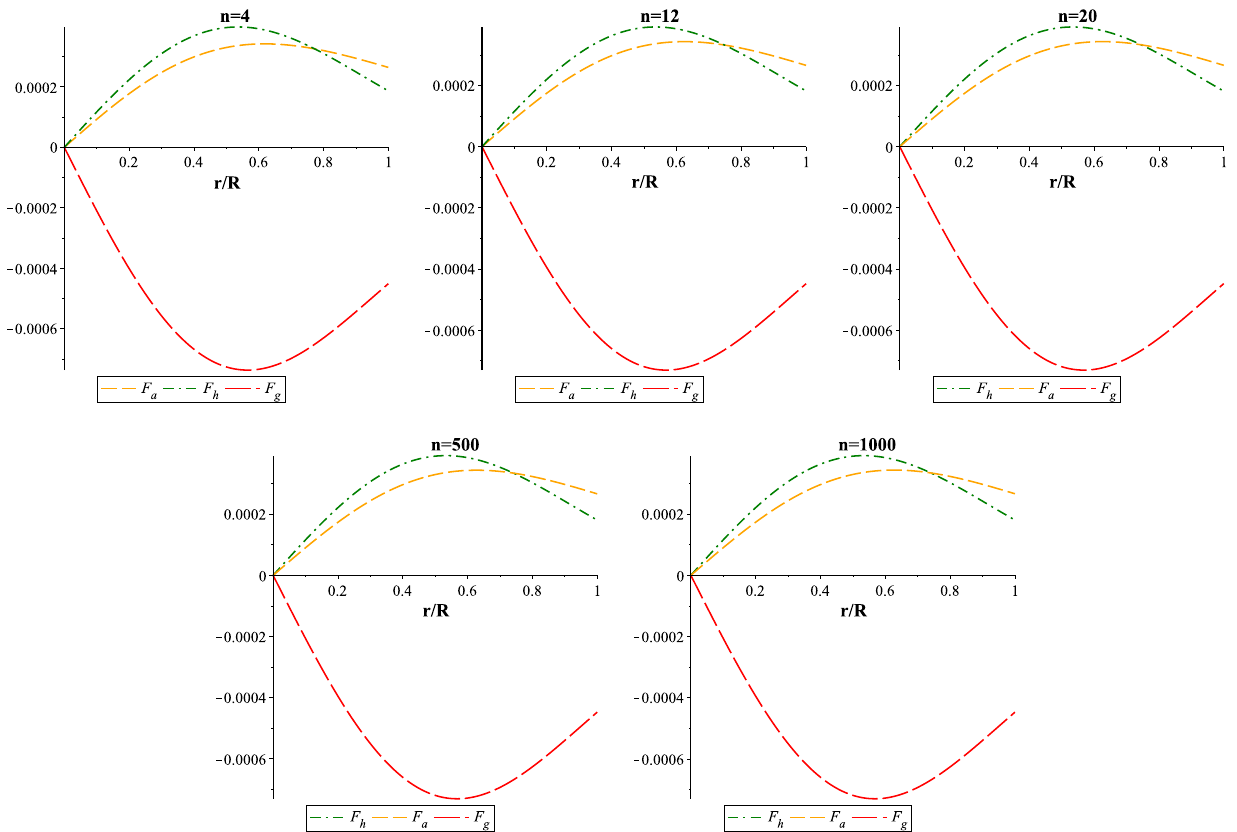
Fig. 8 Variation of the forces ( F i ) with respect to the radial coordinate ( r / R ) for different values of n . For purpose of plotting this figure , the numerical values of the constants for different parameters n are mentioned in Table